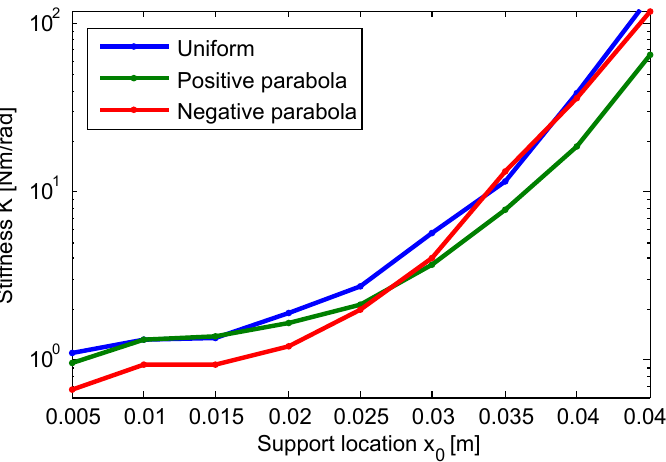
Figure 19. Stiffness plots for the three different leaf spring shapes, making the possibility of shaping the stiffness characteristic of the variable stiffness mechanism (VSM)